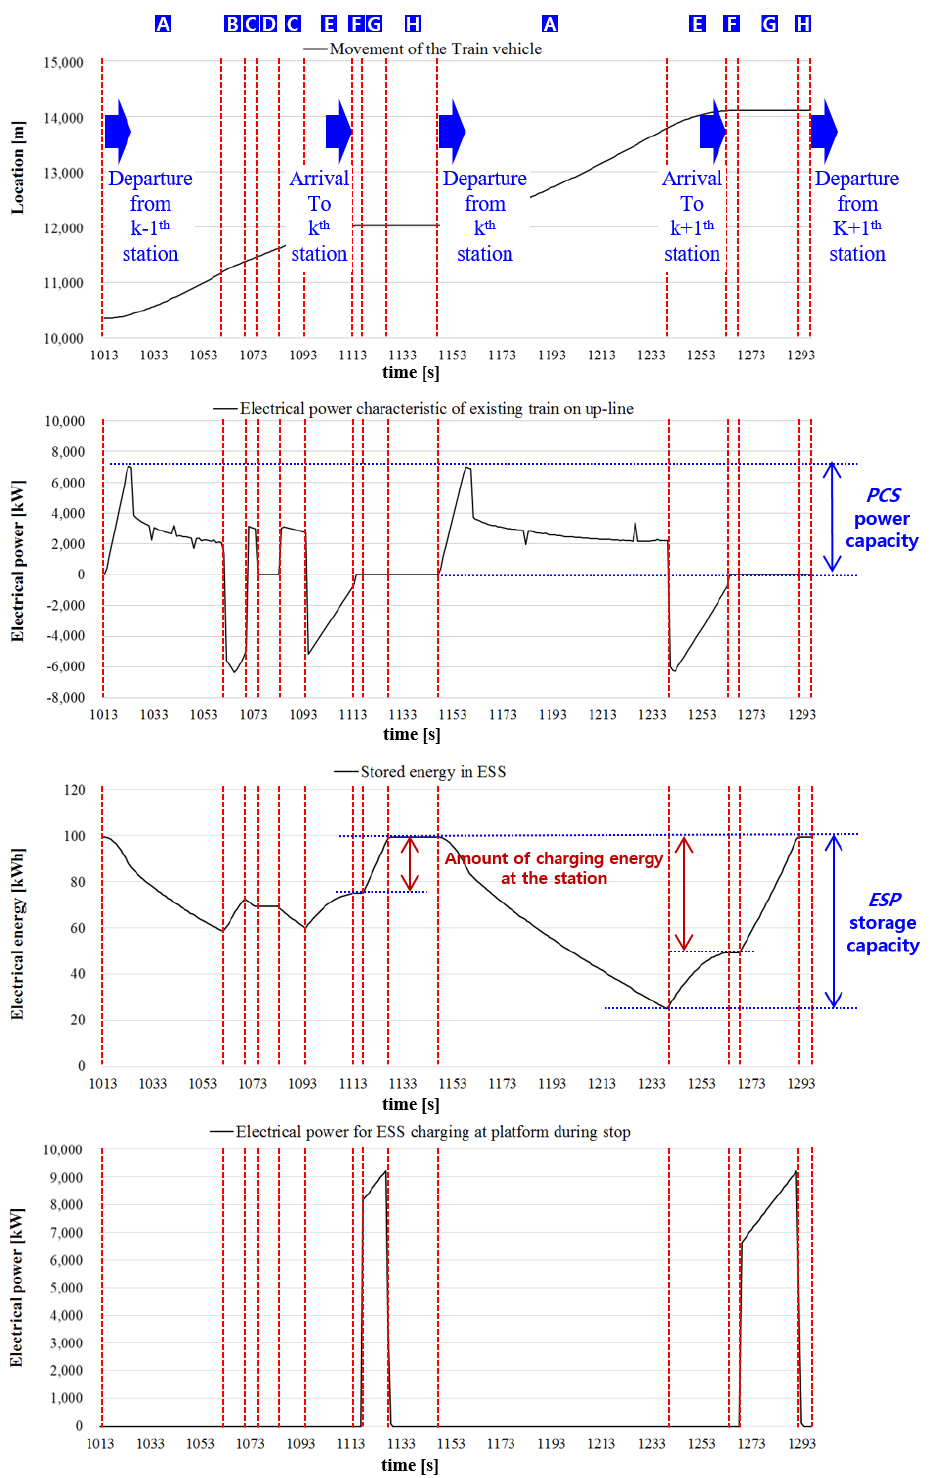
Figure 5. Operation mode of the railway train (location of the vehicle, power characteristics of the existing train, stored energy of the WRT storage, power characteristics of the WRT).